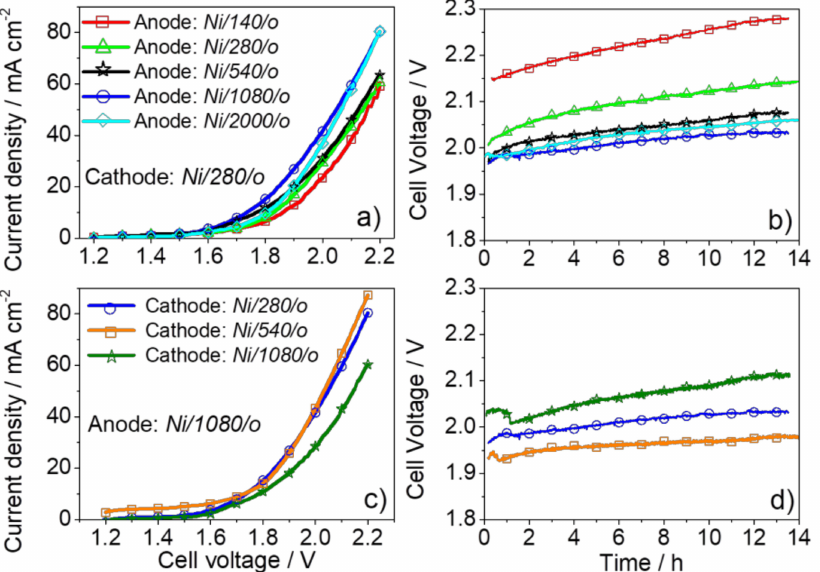
Figure 7. ( a ) LSV curves obtained for MEA assemblies integrating Ni/YY/o anodic electrodes of various equivalent thicknesses and a Fumapem membrane. ( b ) Constant-current (32 mA cm − 2 ) chronopotentiometries measured for the assemblies in ( a ). ( c ) LSV obtained for MEA assemblies with Ni/YY/o cathodes of various equivalent thickness between 280 and 1080 nm and the optimum Ni/1080/o anode. ( d ) Constant-current (32 mA cm − 2 ) chronopotentiometries measured for the assemblies in ( a ). All measurements were carried out in a 1.0 M KOH electrolyte solution at 40 ◦ C. Reprinted with permission from [47]. Copyright 2020 American Chemical